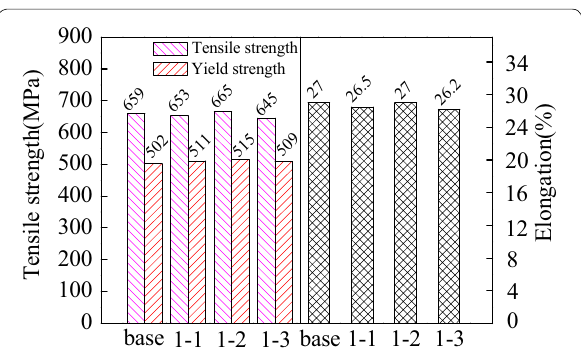
Figure 15 Tensile mechanical properties at 480 °C high